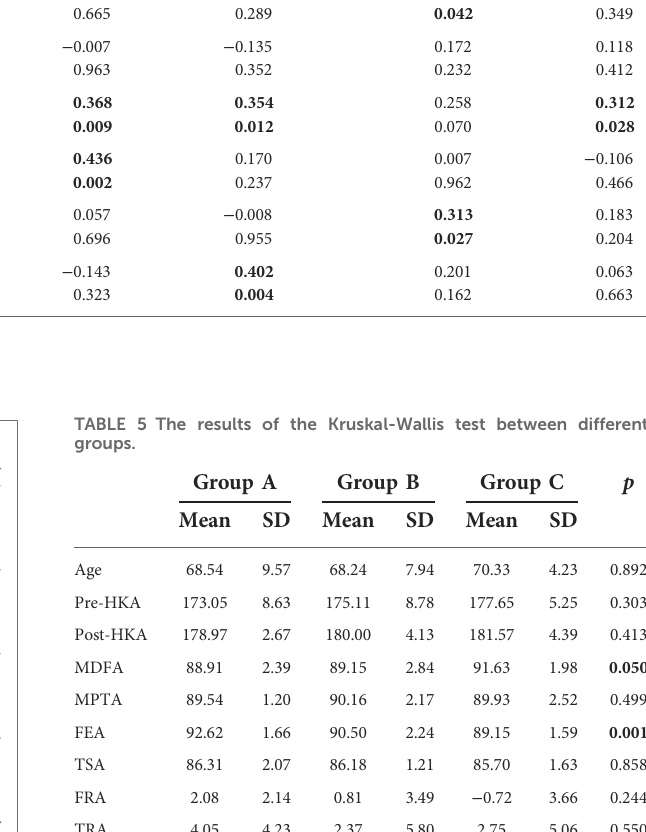
The bold values represents statistically signi fi cant